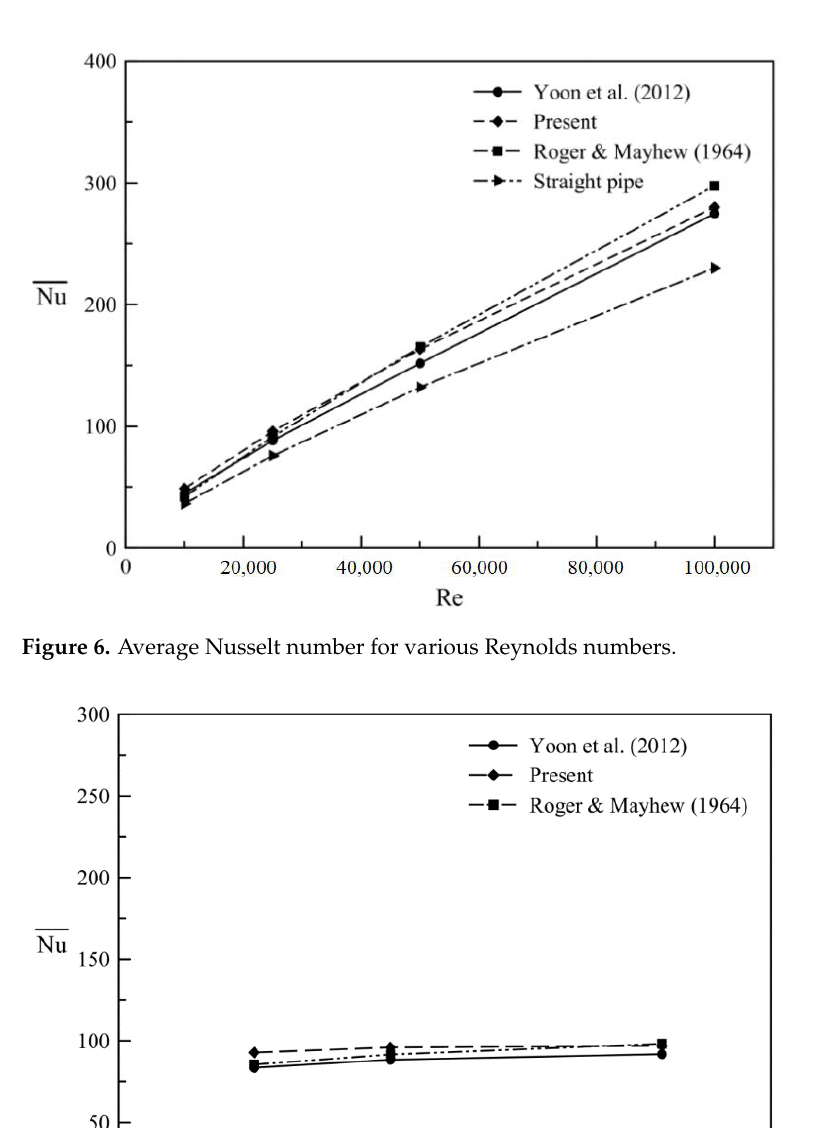
Figure 6. Average Nusselt number for various Reynolds numbers.